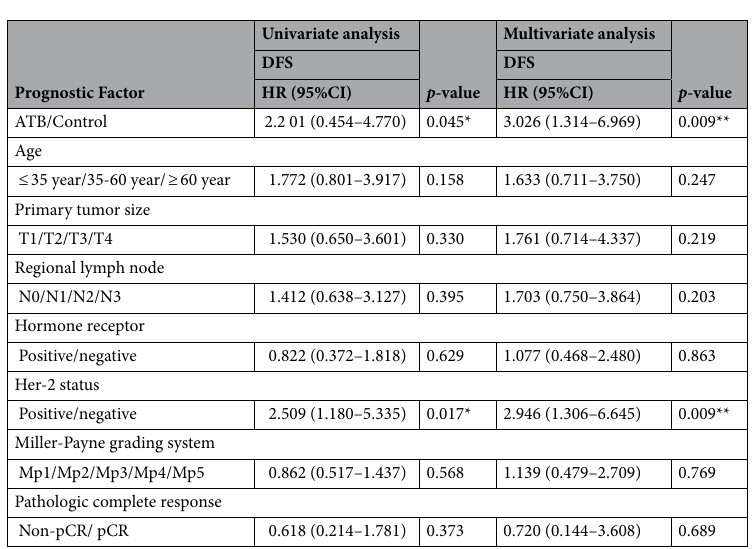
Table 2. Univariate and multivariate analyses of DFS in BC patients. BC breast cancer, DFS disease-free survival, ATB antibiotics; Significant. codes: 0 ‘**’ 0.01 ‘*’ 0.05 ‘.’ 0.1 ‘ ’